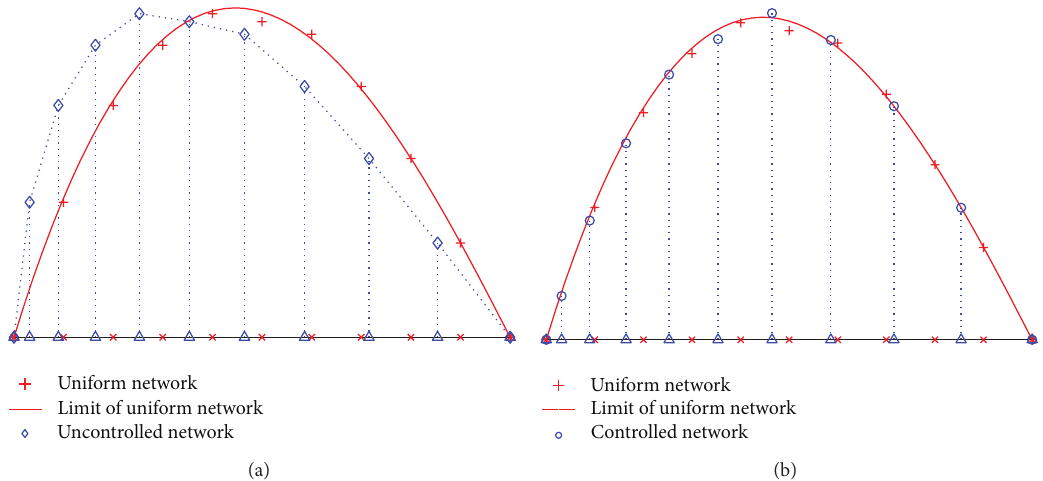
Figure 3: An illustration of control of nonuniform networks. On the 𝑥 -axis, the × marks are the uniform grid, and the Δ marks are the nonuniform node